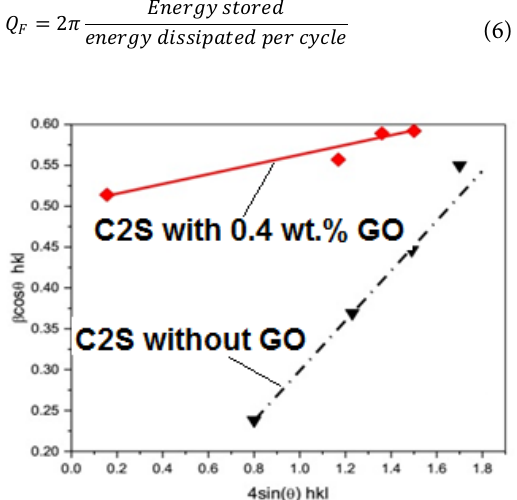
Figure 4. The linear relationship between βcosθ and 4sinθ in the Williamson-Hall diagram (according to the XRD spectra of nanocrystallites of GO/C 2 S silicate, synthesized by Pechini method). Table 6. C, k, Q F and D F of GO/ C 2 S obtained by using GPS 132 A technique where wafer capacitor surface and wafer thickness is A = 1.13 cm 2 and 2 mm, respectively for frequency=1 kHz and 120 kHz Samples